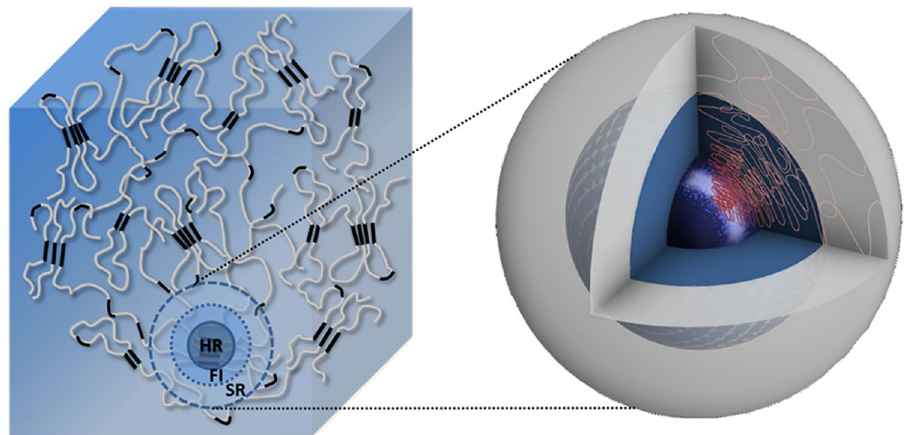
Figure 4. Illustrations of TPU representative volume element and the double-inclusion model. TPU is thought of as consisting of hard regions (HR) embedded within contiguous soft region (SR) matrix, with gradient transitions between HR and SR that are structurally accommodated by the “fuzzy interface” (FI). In the double- inclusion model, at level 1, the inclusions represent the combination of HR & FI, and SR serves as the matrix. At level 2, the inclusion represents only the HR, and FI serves as the